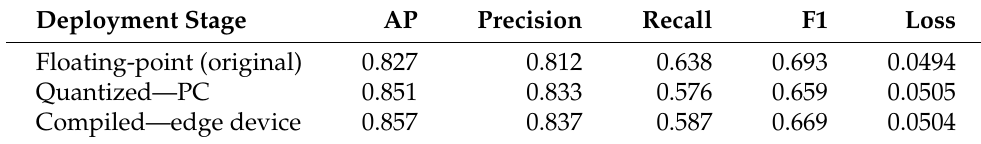
Table 8. The change of metrics across different stages of Deep Moon deployment.